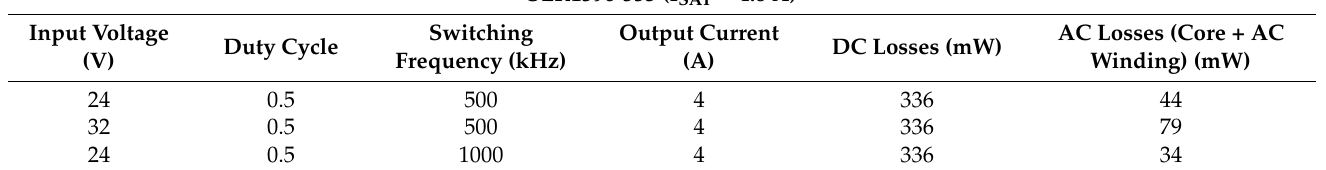
Table 1. Declared losses for two Coilcraft inductor (MSS1260T-273 and SER1390-333) under different operating conditions [16,17].